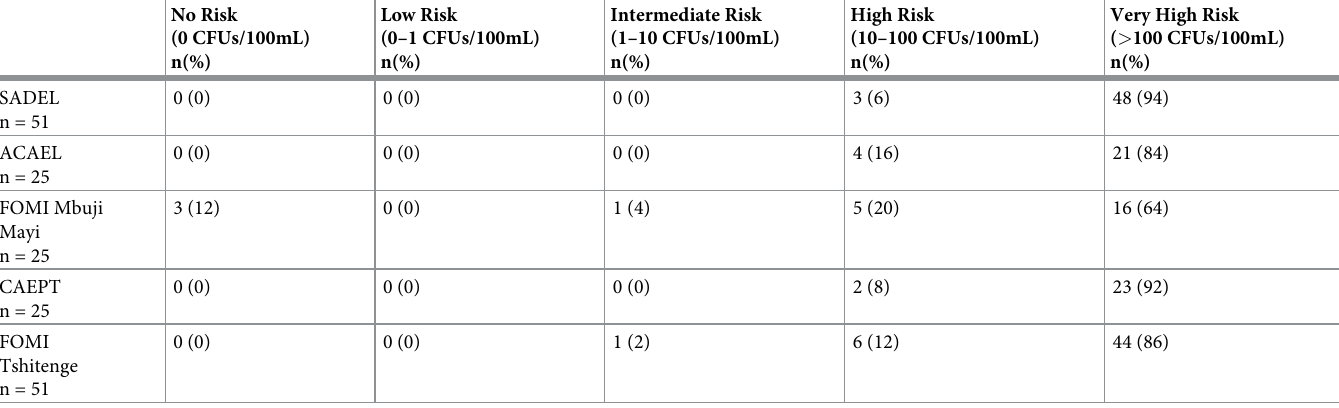
Table 7. Thermotolerant coliform counts within each World Health Organization risk threshold, with samples from points-of-consumption at households within 500m of WSP collection points.. No Risk Low Risk (0 CFUs/100mL) (0–1 n(%)